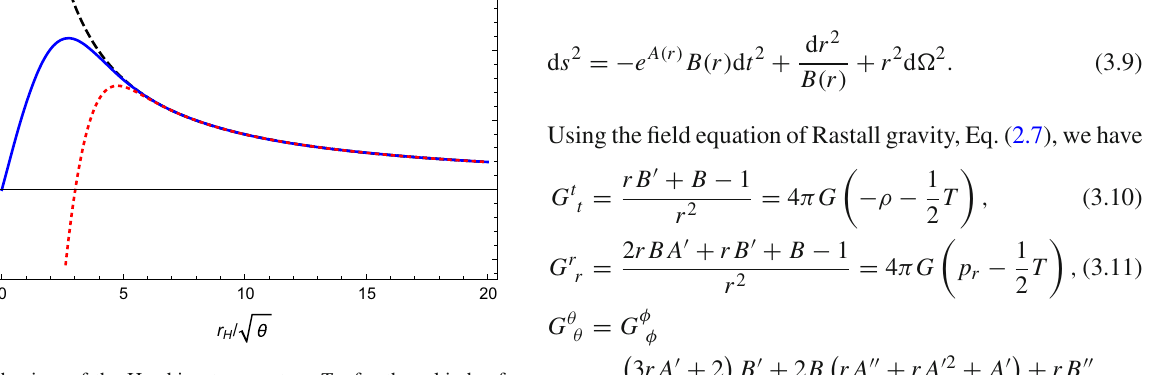
Fig. 2 Behaviors of the Hawking temperature T H for three kinds of blackholes.Thesolid(blue)curvecorrespondstotheNCSBHinRastall gravity.Thedashed(black)curveisthetemperatureforaSchwarzschild black hole. The dotted (red) curve depicts the temperature of NCSBH in